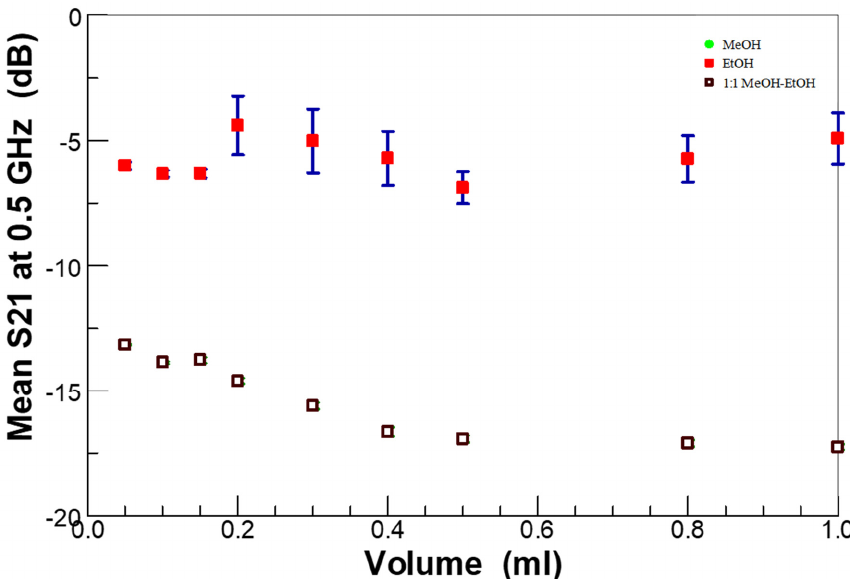
Figure 8. Comparison of solvent concentration dependence of microwave insertion loss amplitude (S 21 ) TCNQ-loaded HKUST-1 on Si substrate at 65 °C, in air, for methanol (MeOH), ethanol (EtOH), and 1:1 mixture of ethanol and methanol, monitored at 0.5 GHz. The 1:1 MeOH-EtOH symbols completely overlap those for pure methanol (MeOH). The error bars represent the standard deviation of at least three measurements.